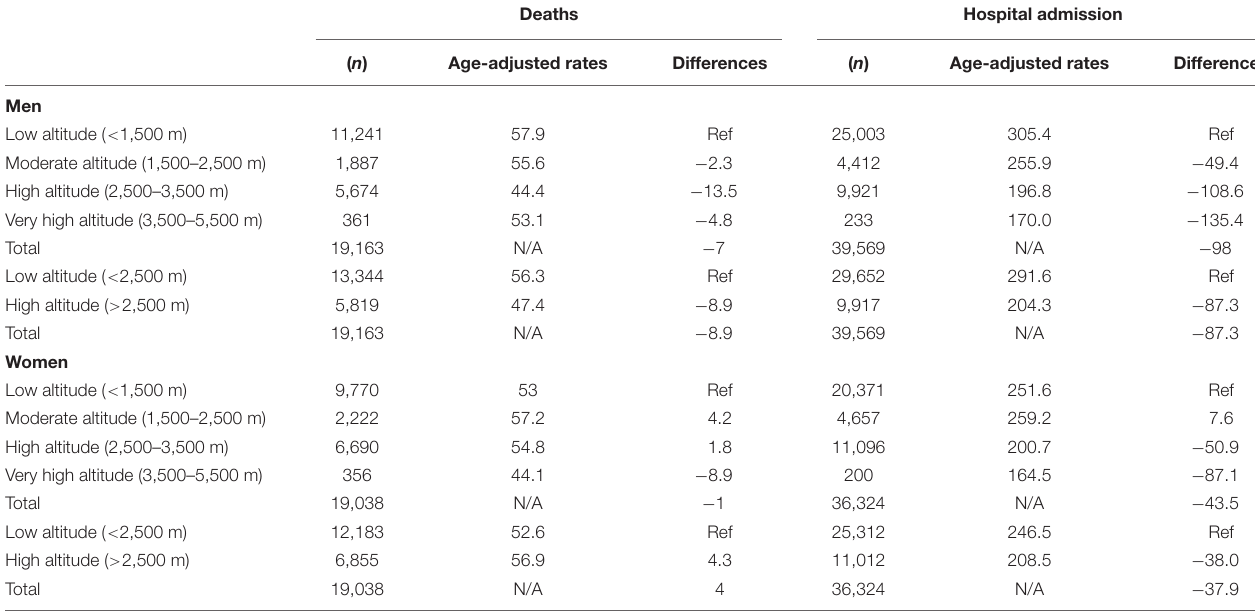
TABLE 2 | Age-sex adjusted mortality and hospital admission stroke rates in Ecuador and the absolute differences in rates when compared to the reference elevation (Low altitude). Deaths Hospital admission ( n )